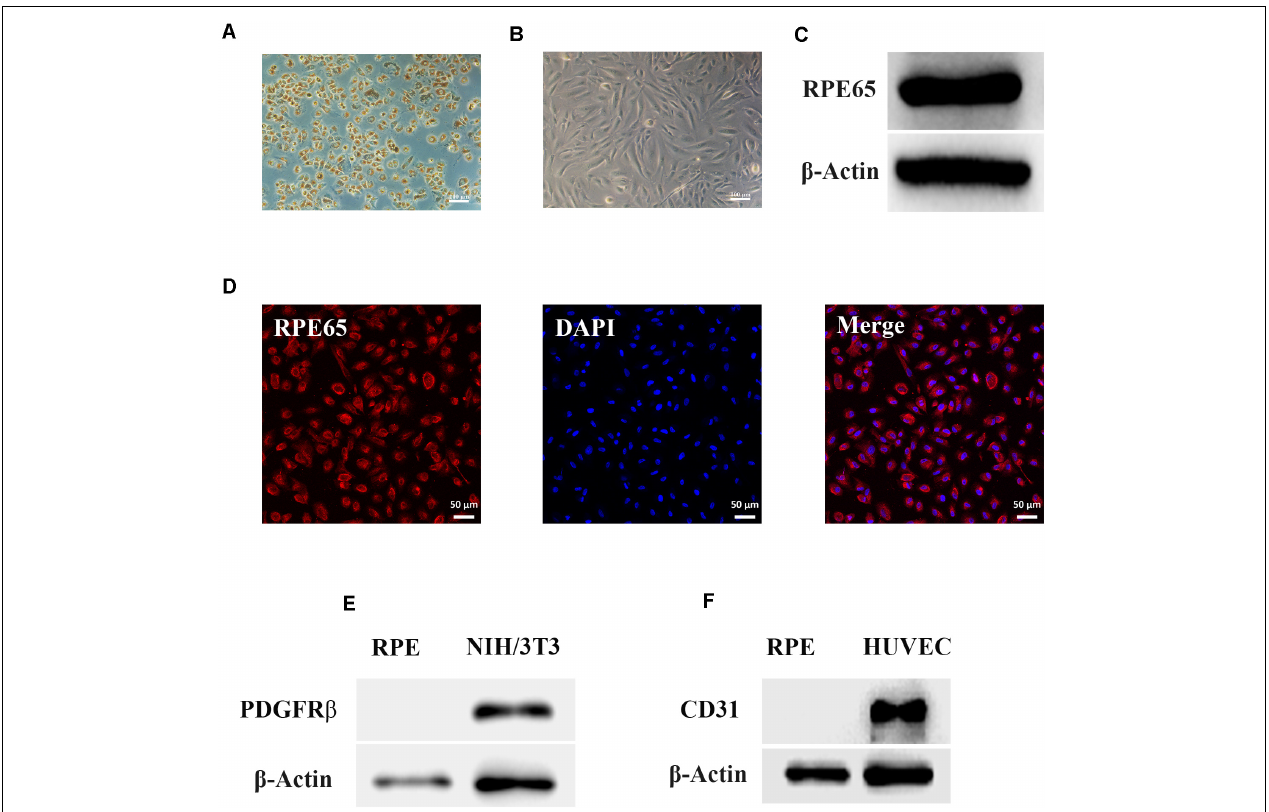
FIGURE 1 | Identification of retinal pigment epithelium (RPE) cells. (A) The morphology of RPE cells from passage 0 by phase contrast microscopy. Scale bar, 100 µ m. (B) The morphology of RPE cells from passage 4 by phase contrast microscopy. Scale bar, 100 µ m. (C) Western blots of RPE65 in RPE cells. β -Actin served as the internal control. (D) Immunofluorescence assays of RPE65 in RPE cells. Scale bar, 50 µ m. (E) Western blots of PDGFR β in RPE cells. NIH/3T3 cell was used as the positive control. β -Actin served as the internal control. (F) Western blots of CD31 in RPE cells. Human umbilical vein endothelial cell (HUVEC) was used as the positive control. β -Actin served as the internal